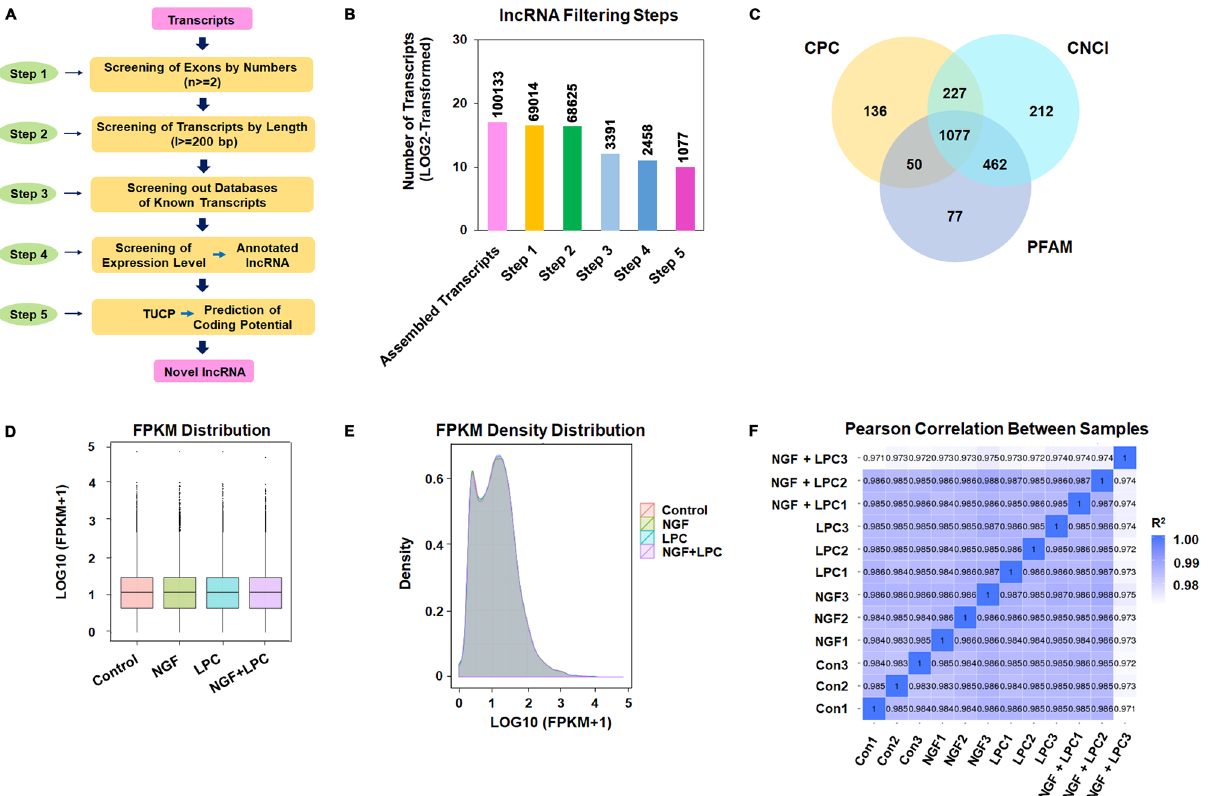
Figure 1. Identification of lncRNAs in PC12 cell lines. ( A ) Flow chart of lncRNAs analysis; ( B ) Histogram representation of lncRNAs filtration; ( C ) Venne diagram of novel lncRNAs predicted based on CPC, CNCI and PFAM; ( D ) FPKM distribution analysis among four experimental groups; ( E ) FPKM density analysis among four experimental groups; ( F ) Pearson coefficient analysis four experimental